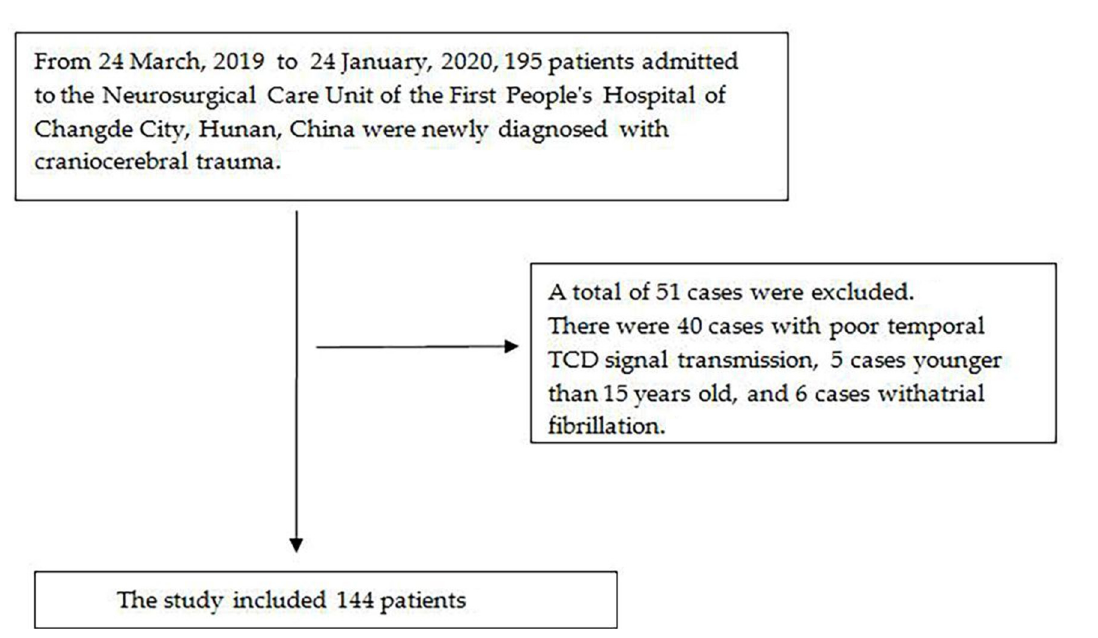
Table 1. Baseline characteristics of the participants. ( n = 144).